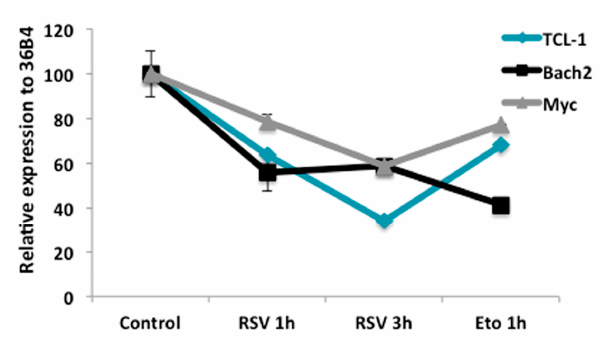
Figure 5. Effect of Resveratrol on the expression of proliferative genes essential in lymphomagenesis. The mRNA levels of proliferative were measured by quantitative reverse transcriptase polymerase chain reaction. Cells were treated with 100 µM resveratrol (RSV) for 1 h or 3 h. The graph represents the relative expression of TCL-1 (T-cell leukemia/lymphoma protein 1A), Bach2 and Myc genes. Results are representative of three independent experiments, * p < 0.05.